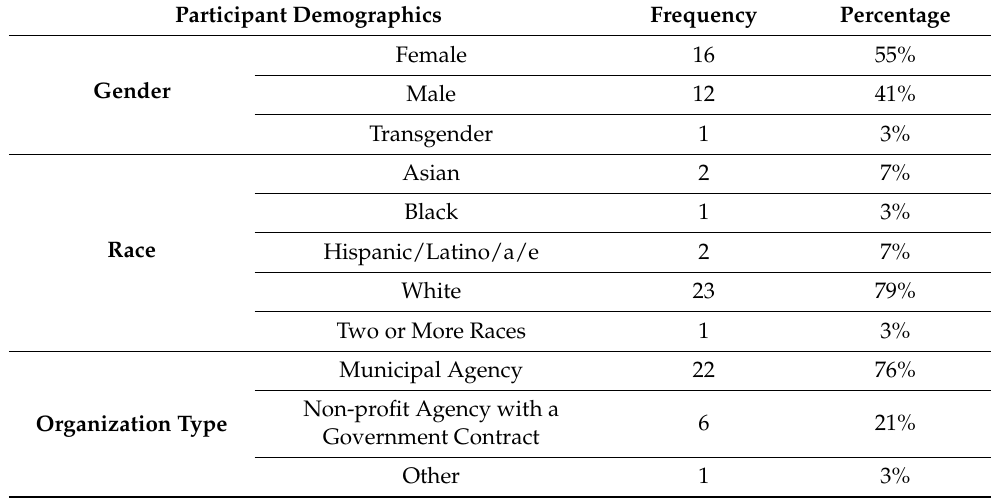
Table 1. Demographics of the Sample ( n =